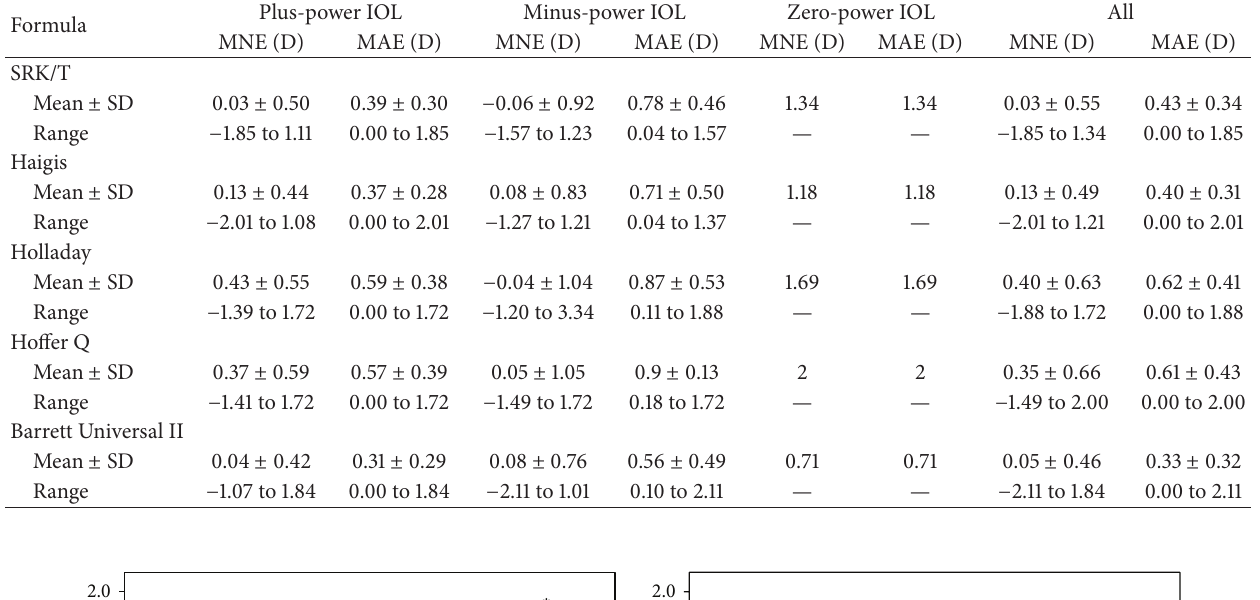
Table 3: Mean numerical error (MNE) and mean absolute error (MAE) for formulas and groups.